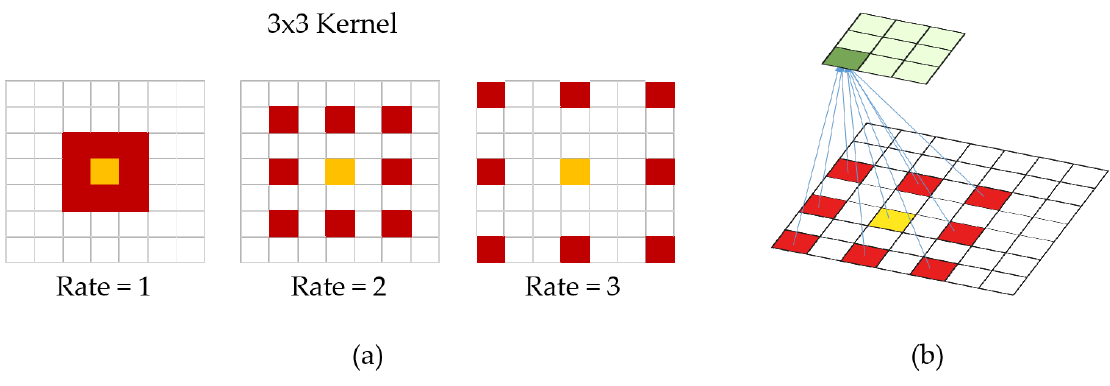
Figure 6. ( a ) examples of dilated convolutions. When dilation rate is 1, it becomes normal convolution. ( b ) 3D appearance of dilated convolution (rate =